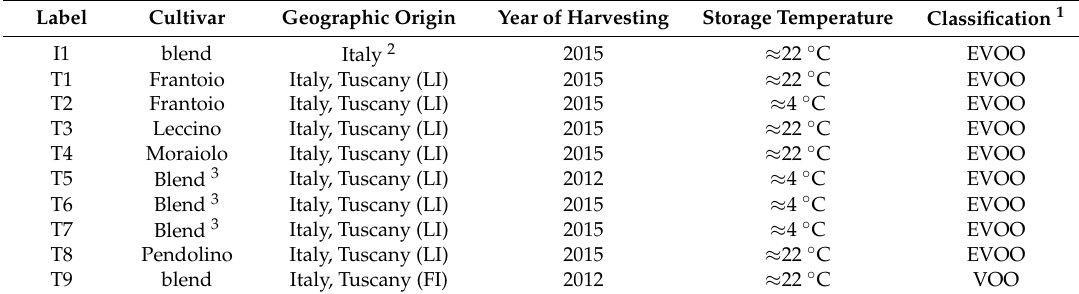
Table 1. Samples of Italian olive oils: Extra-virgin and virgin ones, mono-cultivar, and blend of different cultivars are indicated. The label of each sample, the geographic origin, and temperature of storage are also